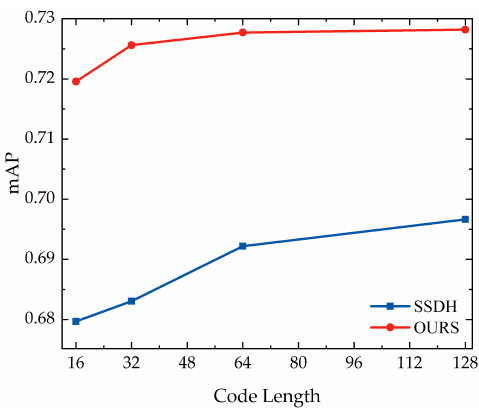
Figure 10. Precision–recall curves and top-N precision with code length 32.